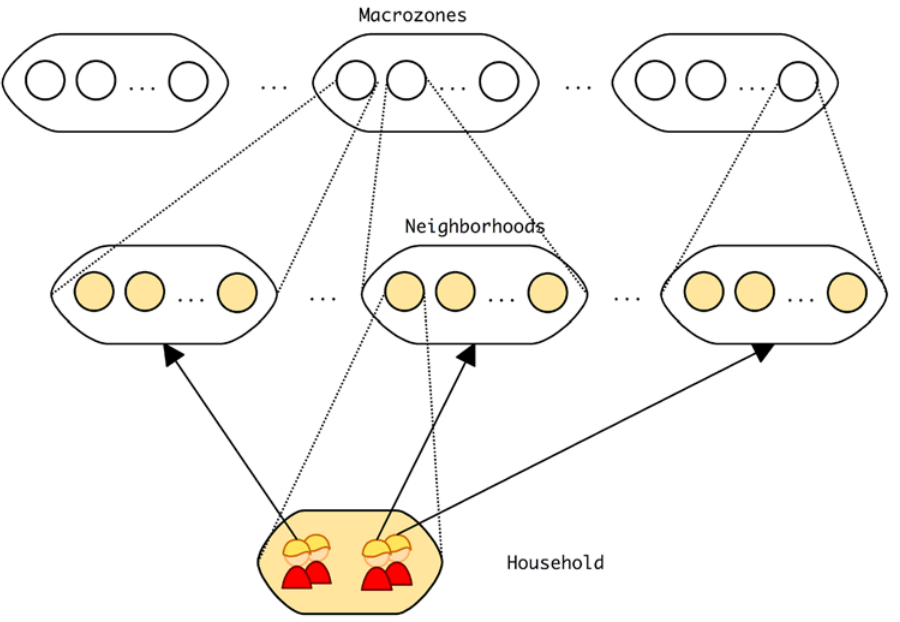
Figure 9. Design of the hierarchical population model. Arrows show the possible patterns of daily movement of individuals.